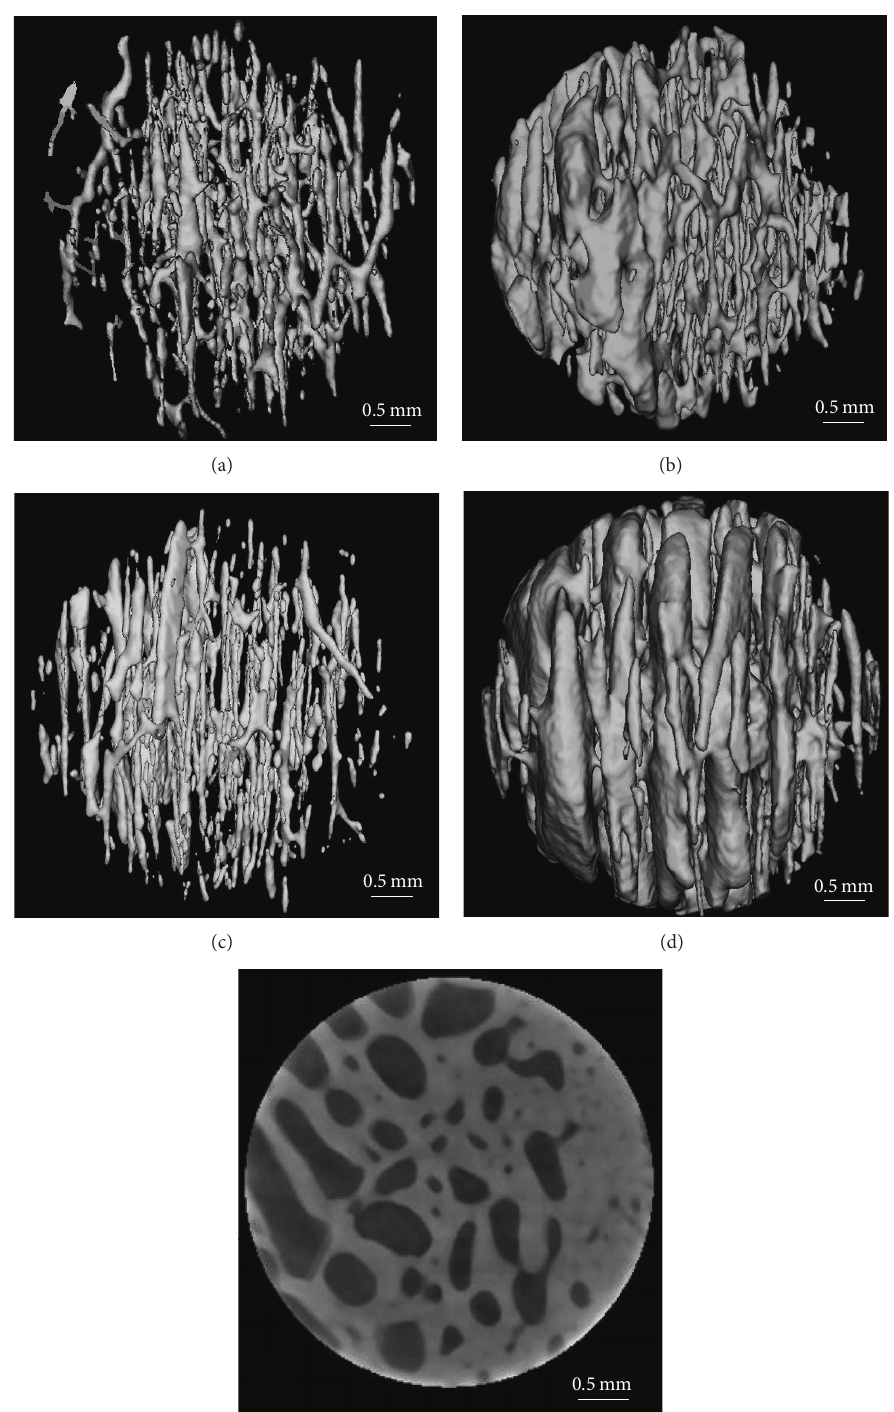
Figure 2: 3D reconstructed images of cortical porosity at the inferior femoral neck from a man aged 62 years (a), a man aged 92 years (b), a woman aged 62 years (c), and a woman aged 92 years (d). There are more enlarged pores in the 92-year-old group than those of the 62-year-old group. Representative 2D micro-CT image of the femoral neck cortex from a woman aged 92 years (e) is shown. The periosteal surface faces right for all specimens